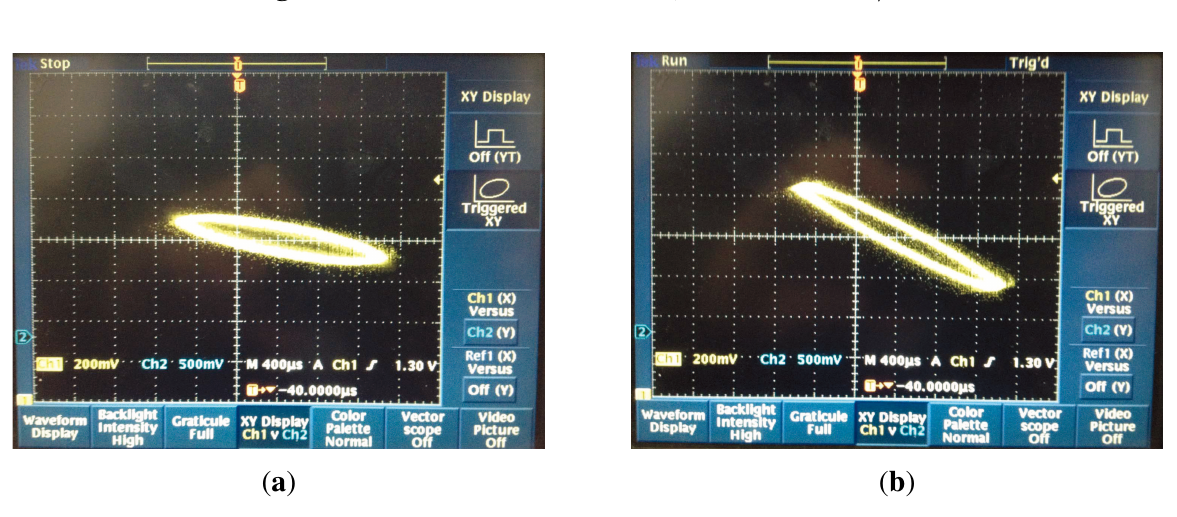
Figure 17. Picture of coriolis test. ( a) Ω = 0 . (b) Ω (cid:54) = 0